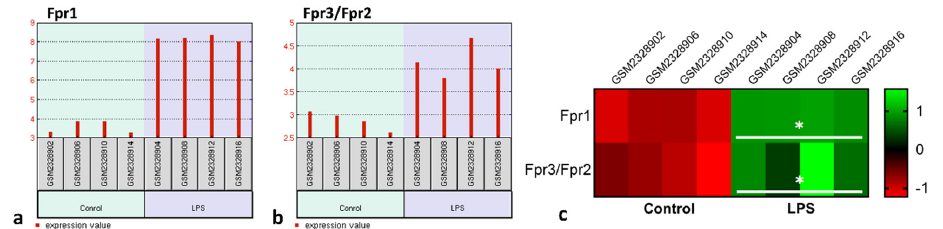
Figure 2. LPS stimulation increases Fpr RNAm levels in macrophages. Experimental design: Fpr1 and Fpr3/Fpr2 transcriptional levels in control and LPS-stimulated macrophages (1 µg/mL) was analyzed by bioinformatic analysis from GSE87369 study containing publicly available transcriptome data. ( a,b ) Fpr1 and Fpr3/Fpr2 gene expression profile graphs. Each red bar represents the expression measurement extracted from the value column of the control and LPS-stimulated cells. The sample accession numbers and groups are listed along the bottom of the chart. ( c ) Heatmap based on the Z-scores of Fpr1 and Fpr3/Fpr2 transcriptional levels in the control and LPS-stimulated RAW cells (GSE87369). * p < 0.05 vs. Control ( t